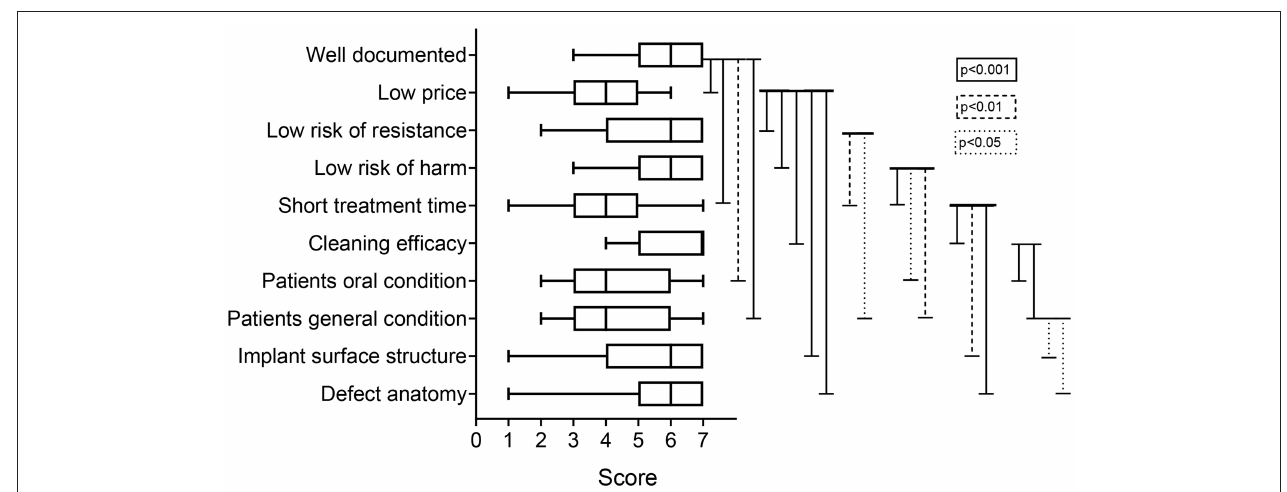
FIGURE 3 | Box-plot with score of importance of listed criteria when choosing implant-cleaning procedures.